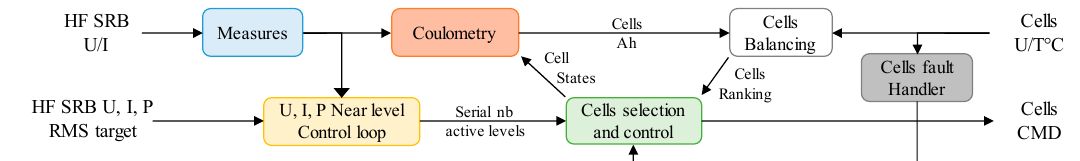
Figure 4. Block diagram of the HF SRB control algorithm performed in the master controller.